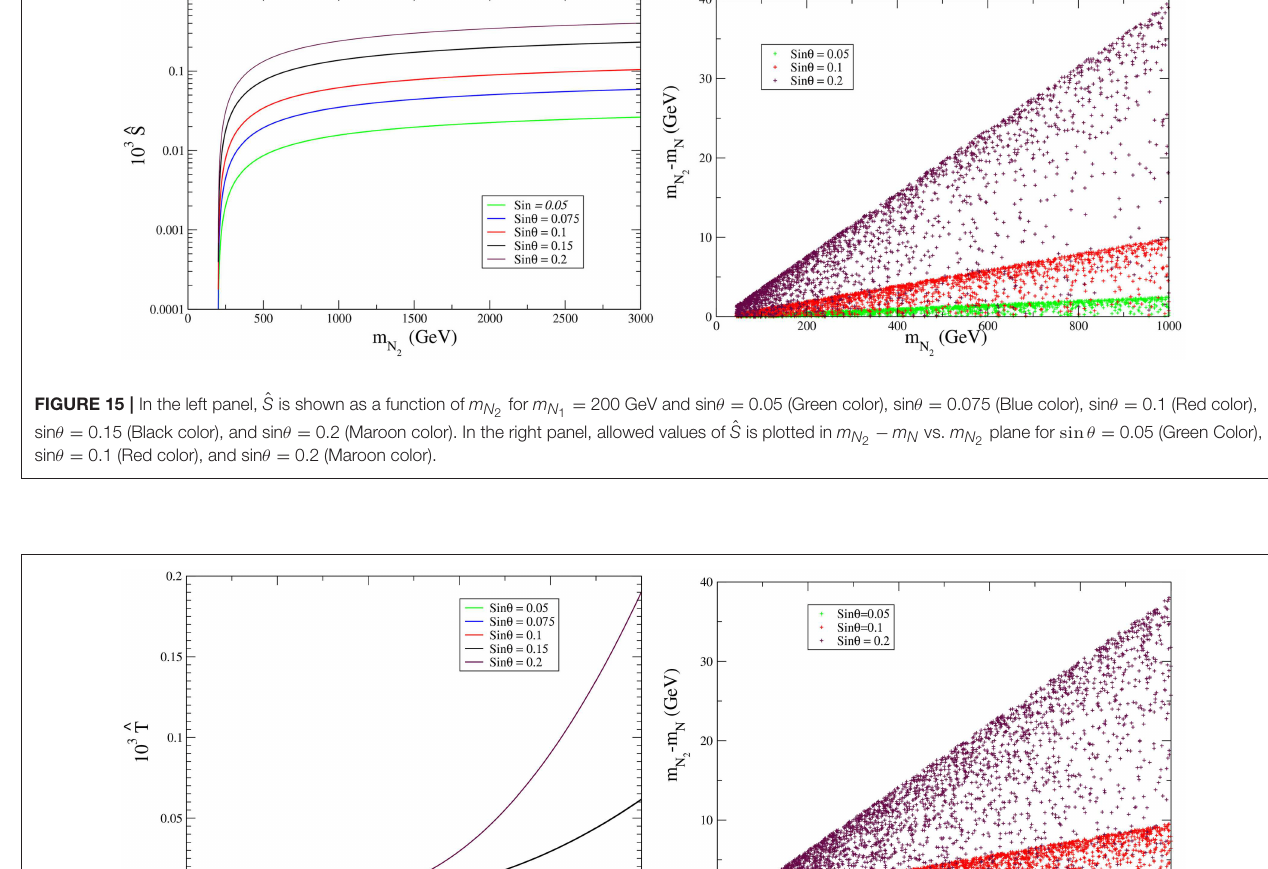
for m N 200 GeV and sin θ 2 1 =